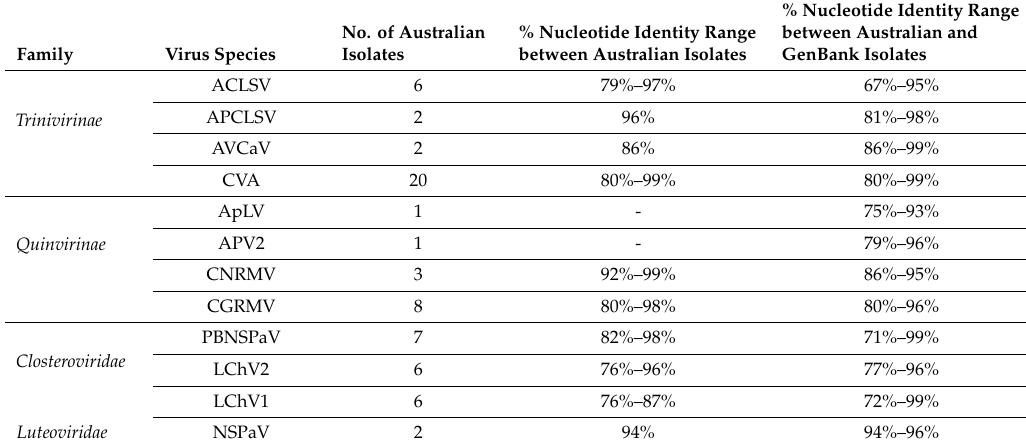
Table 5. The percentage (%) nucleotide identity comparison of full genome sequences of isolates detected in this study by metagenomic HTS and corresponding full genome sequences of isolates available in GenBank are